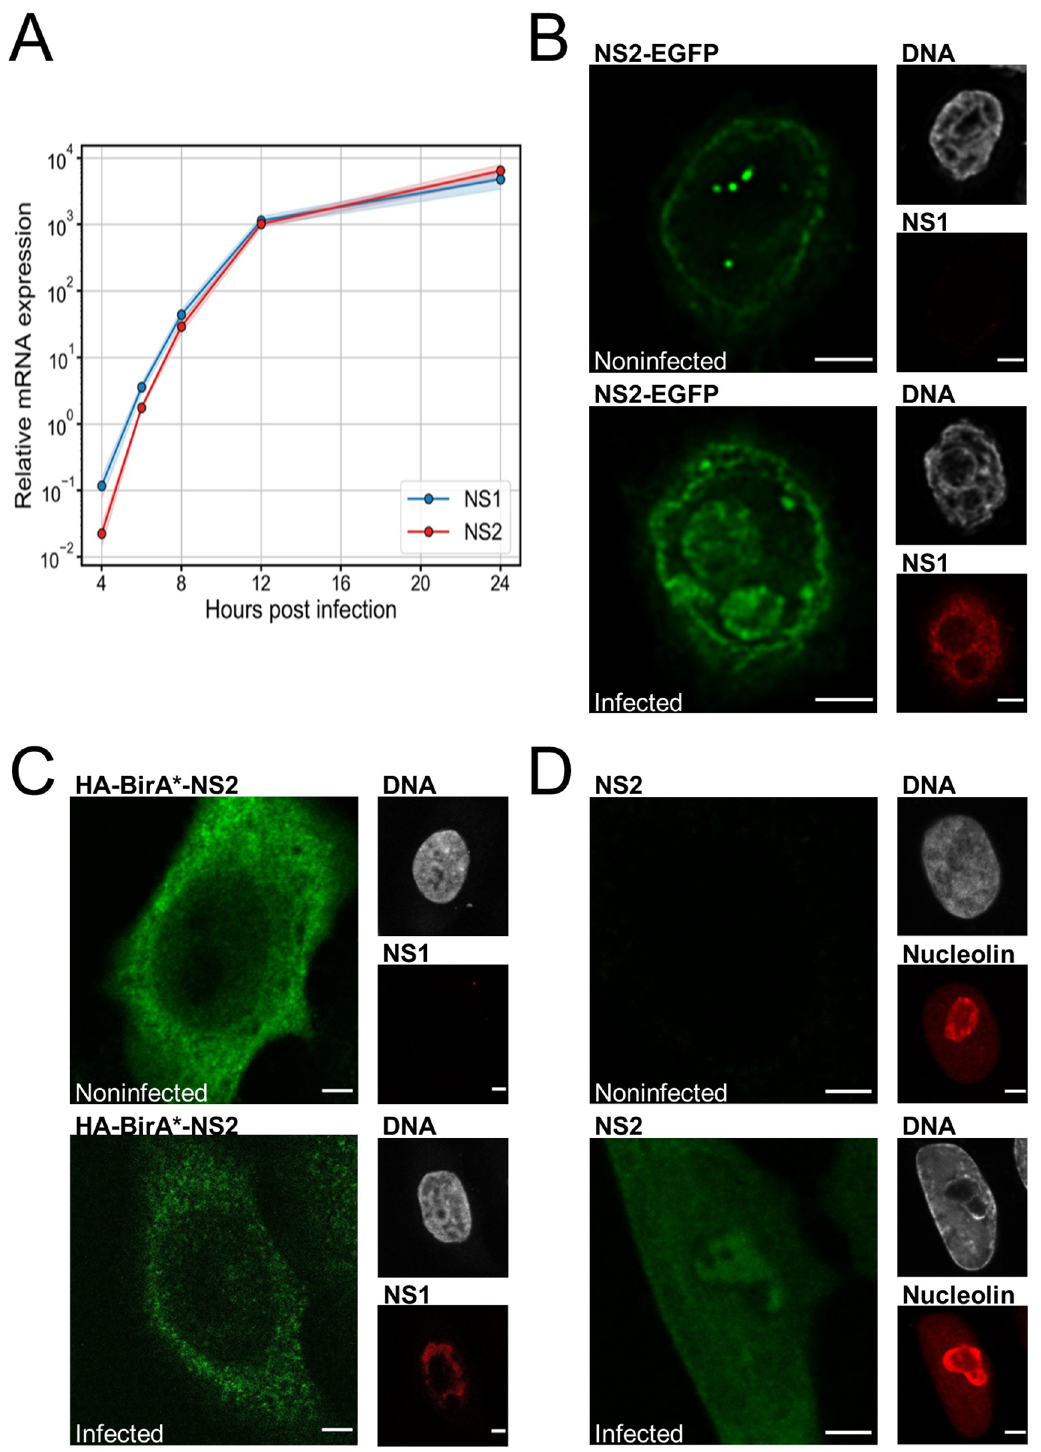
Fig 1. CPV infection leads to simultaneous expression of NS1 and NS2 genes and nucleolar accumulation of NS2. (A) Relative expression levels of NS1 (blue) and NS2 (red) measured by RT-qPCR in infected NLFK cells between 4 and 24 hours post infection (hpi). The blue and red shadings around the lines indicate the standard error of the mean (SEM, n = 3). ( B ) Representative confocal images of HeLa cells transfected with NS2-EGFP (green) and ( C ) BirA � -tagged NS2 (green) at 24 hpt in noninfected and infected cells at 24 hpi. The localization of NS1 (red) is shown in cells with DAPI-stained nucleus (gray). ( D ) Representative confocal images of noninfected and infected NLFK cells at 24 hpi stained with antibodies against NS2 (green) and nucleolin (red). Gray corresponds to DAPI staining of DNA. Scale bars, 3 μ m. https://doi.org/10.1371/journal.ppat.1010353.g001 PLOS Pathogens| https://doi.org/10.1371/journal.ppat.1010353 April 8,